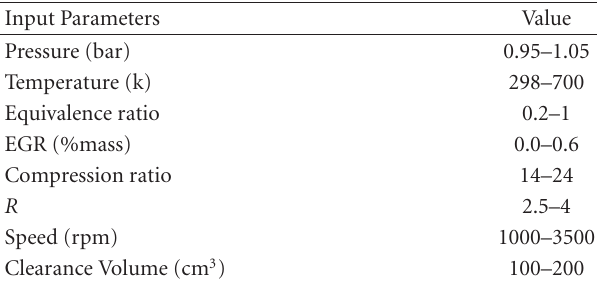
Figure 3: Methodology for finding the main heat release for Meth- ane as a single-stage ignition fuel.